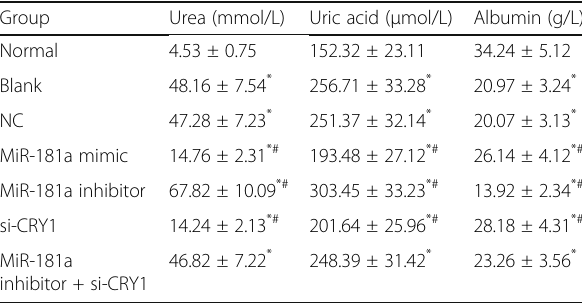
Table 2 Upregulation of miR-181a or downregulation of CRY1 decreases the contents of urine albumin, uric acid, urea of CKD